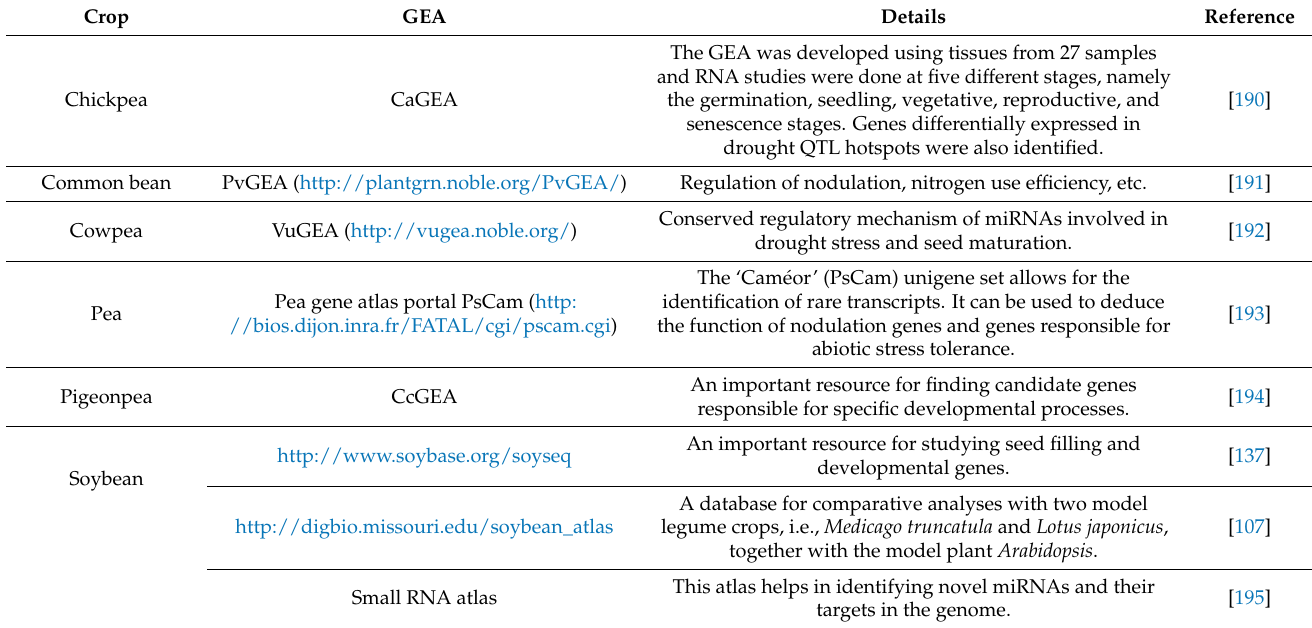
Table 6. High-resolution gene expression atlases (GEAs) for different pulse